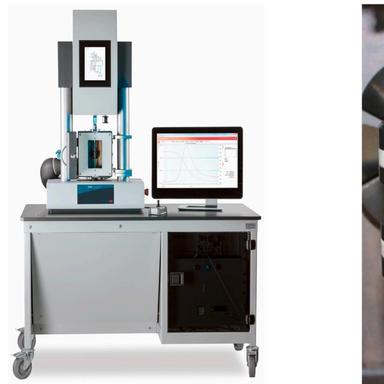
DiPLEXOR® 500 N for simultaneous dynamic-mechanical and dielectric analysis (a) and sample holders for rheodielectric measurements in compression mode (b) .